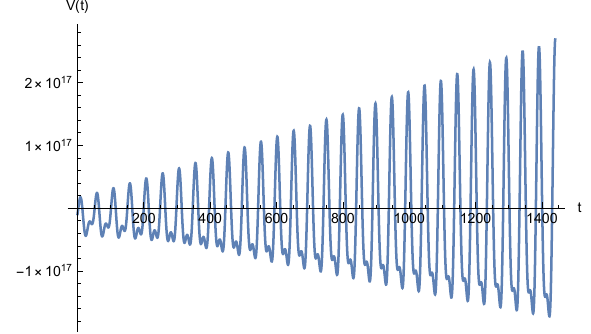
Fig. 3 Visibility Intervals Between AQUA and ARIRANG2 24-H with Oblateness Force